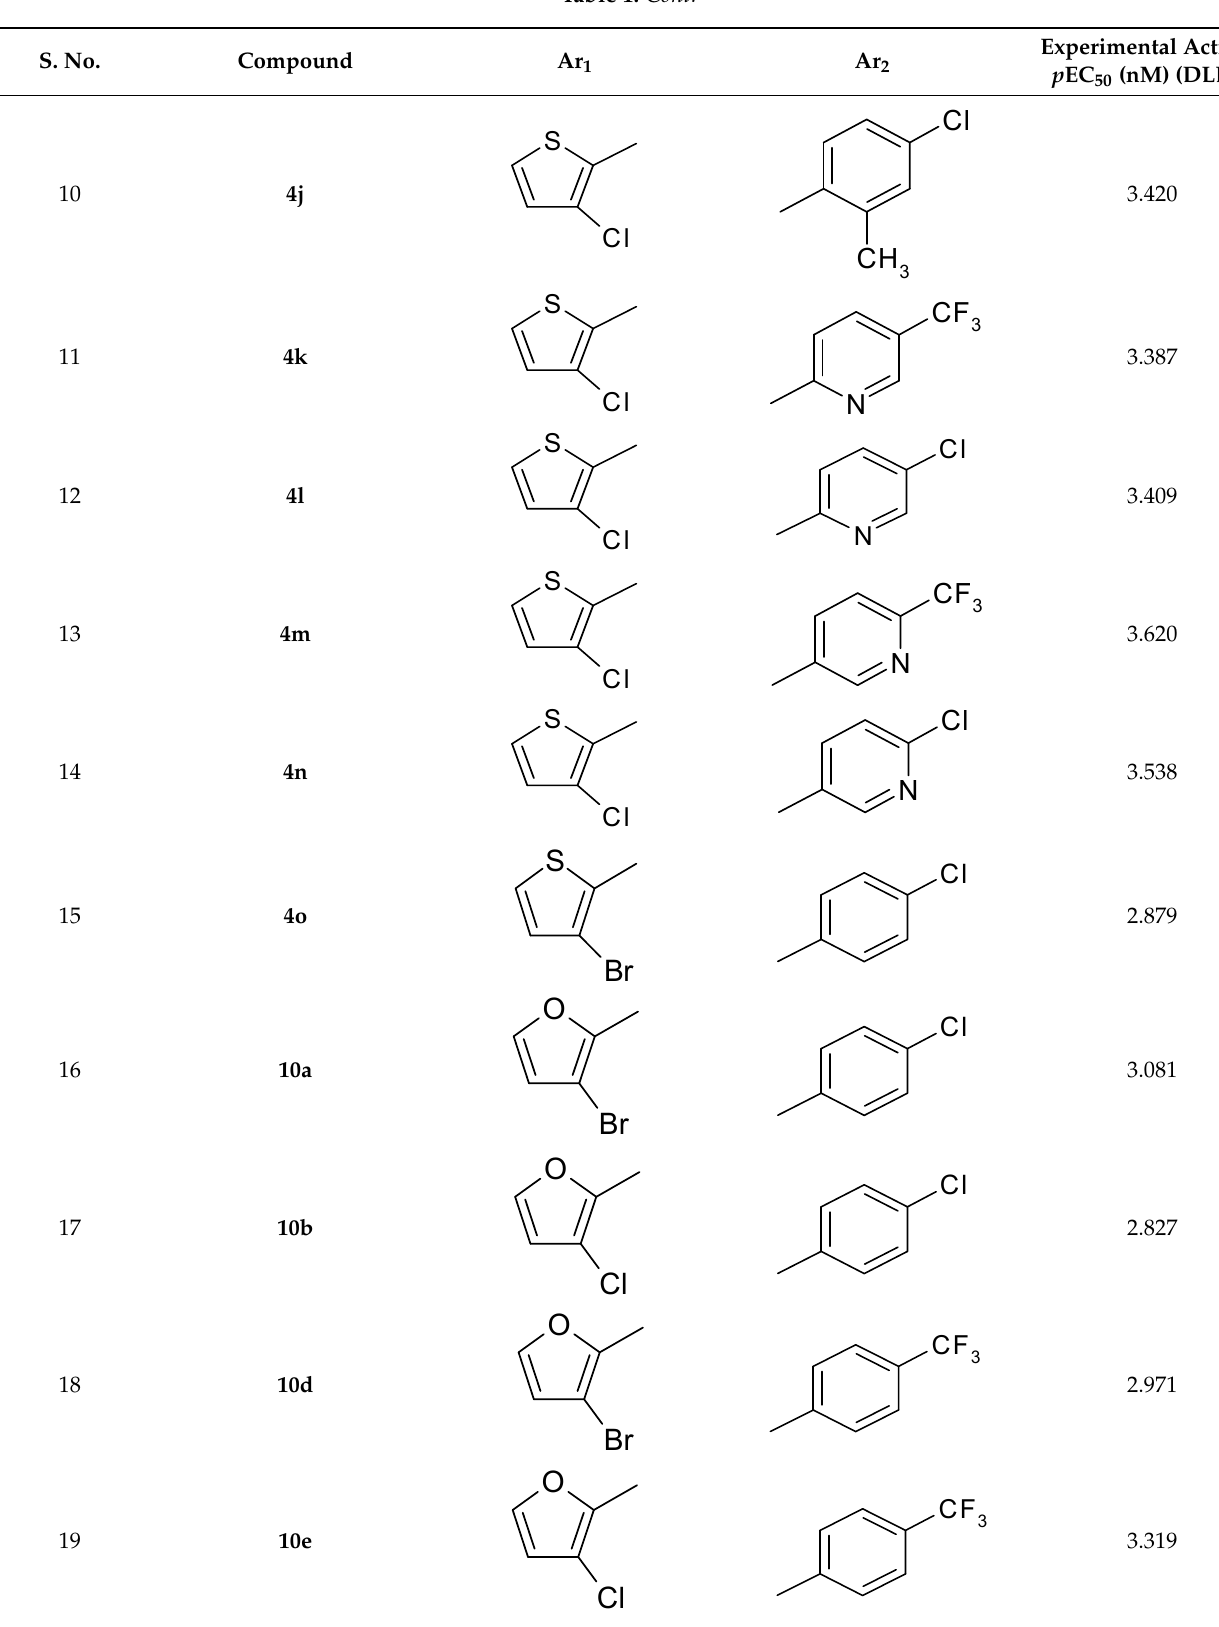
Table 1. 1,2,4-Oxadiazole analogues and their experimental caspase-3 activator activity.